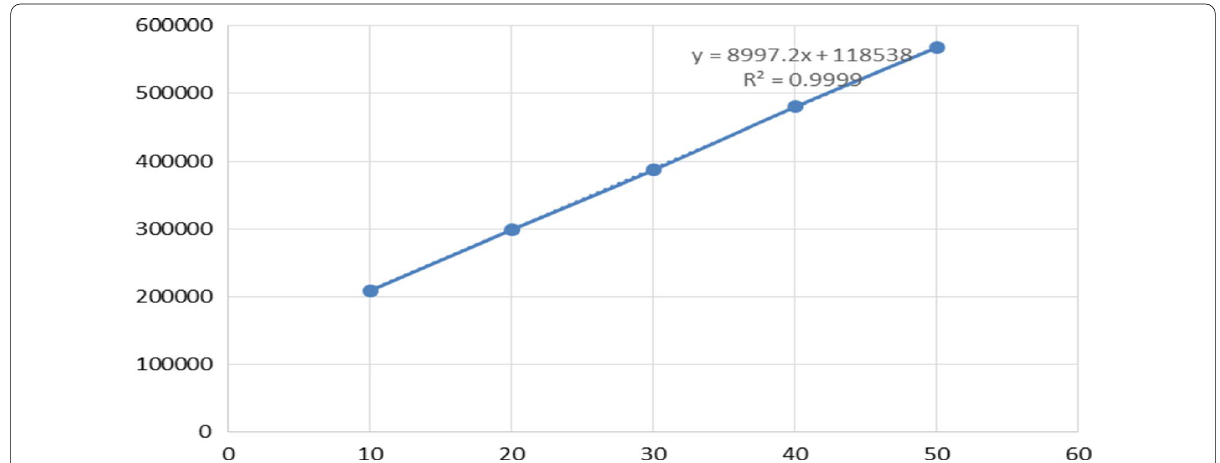
Fig. 4 Calibration curve of